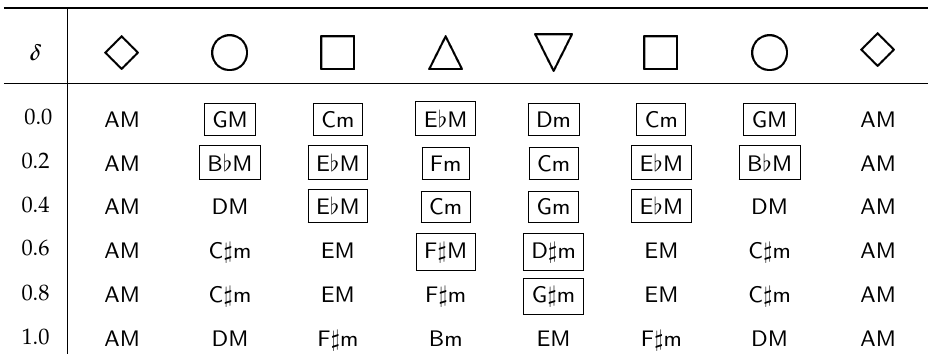
Table 2. The highest probability generated sequence instantiating the indicated eight-chord cyclic pattern, varying the diatonicity δ . The variable 6 is locked to the chord AM and non-diatonic chords in A major are